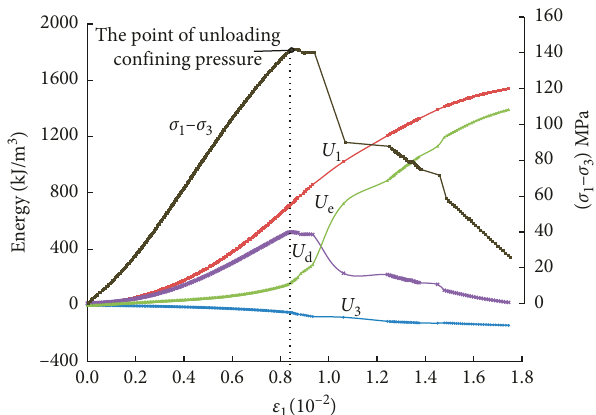
Figure 4: Strain energy conversion for the rock specimen ( σ 3 � 15